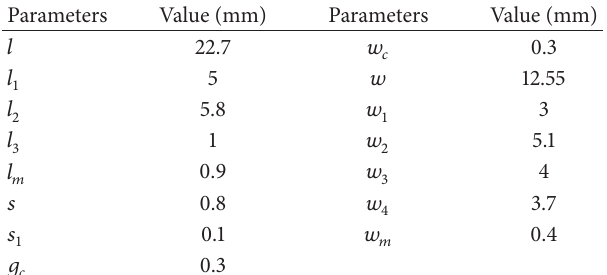
Figure 6: Photographs of the fabricated